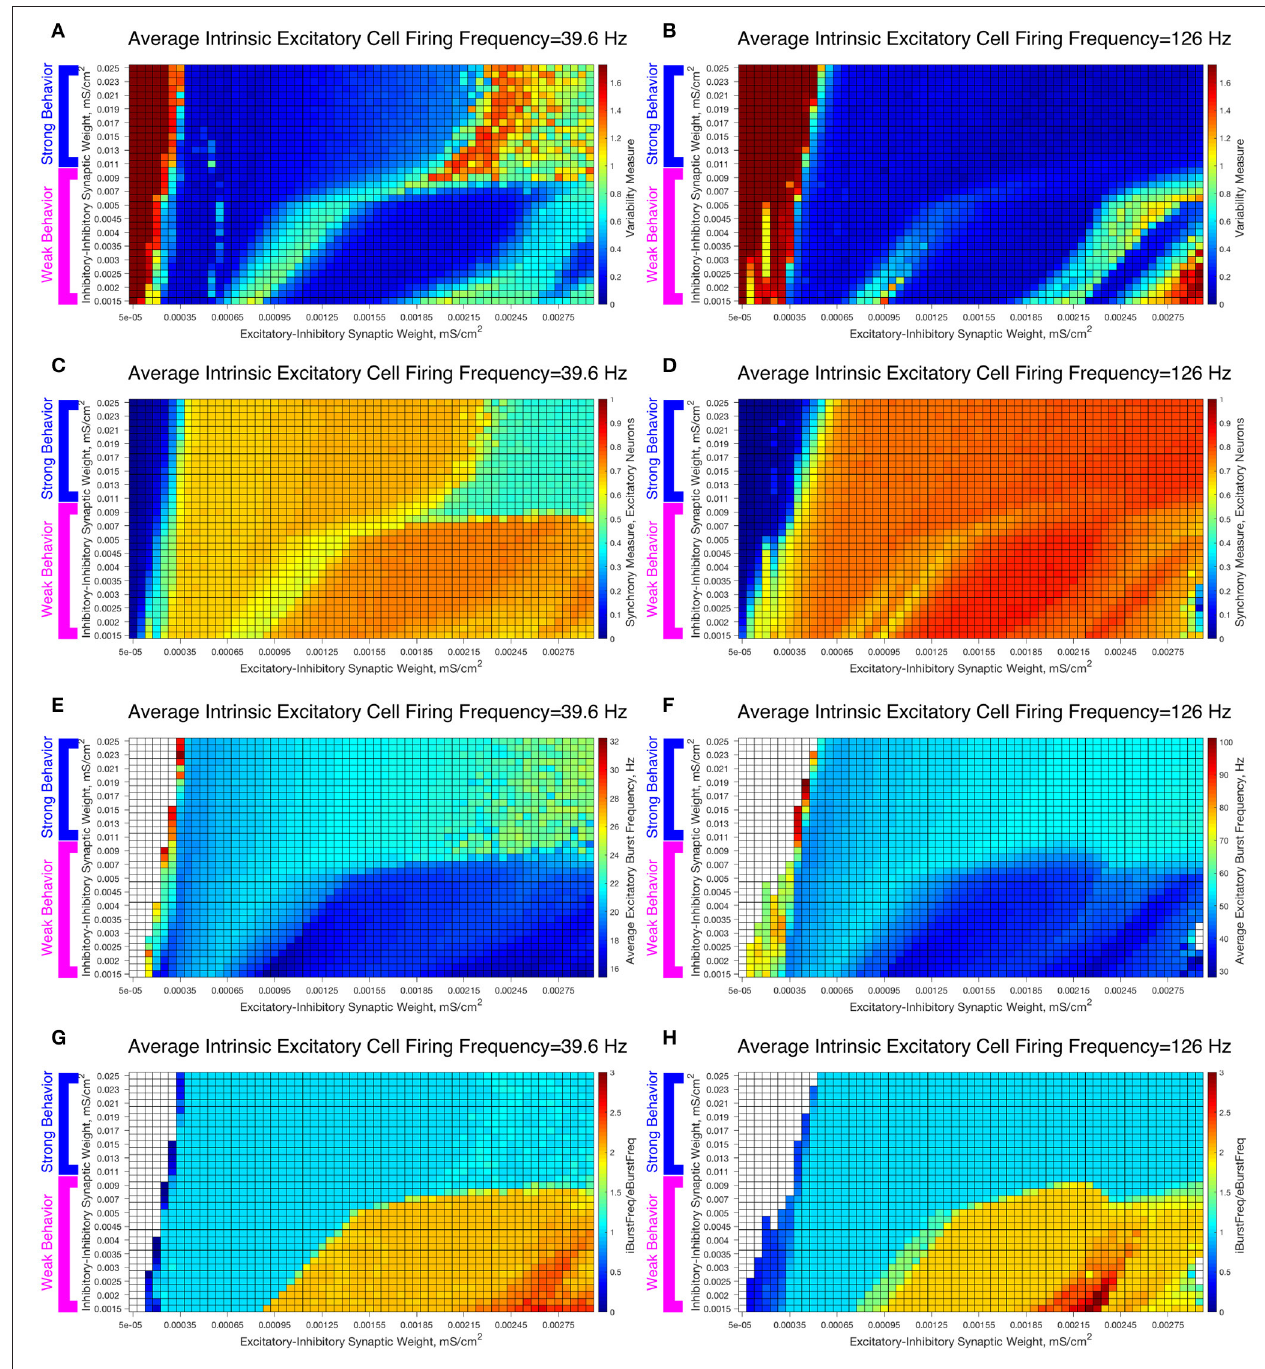
FIGURE 7 | Varying the I-I synaptic weight reveals that E-I networks display two distinct dynamical patterns directly analagous to those seen in our networks with weakly connected or strongly connected inhibitory subnetworks. (A–H) Heatmaps varying the E-I synaptic weight on the x-axis and I-I synaptic weight on the y-axis for networks with an average intrinsic excitatory cell firing frequency of 39.6 Hz (A,C,E,G) and 126 Hz (B,D,F,H) . Four measures are shown: the Variability Measure (A,B) , the Synchrony Measure for Excitatory Neurons (C,D) , the Average Excitatory Burst Frequency in Hz (E,F) and the ratio of the Average Inhibitory Burst Frequency over the Average Excitatory Burst Frequency (G,H) . White boxes in the heatmaps indicate that the excitatory network did not achieve sufficient synchrony for the given measure to be accurately calculated for that network. Values of I-I connectivity strength that exhibit behavior corresponding with that seen in our network with a weakly connected inhibitory subnetwork are highlighted by the pink bracket, while values that exhibit behavior corresponding with that seen in our network with a strongly connected inhibitory subnetwork are highlighted by the blue bracket.